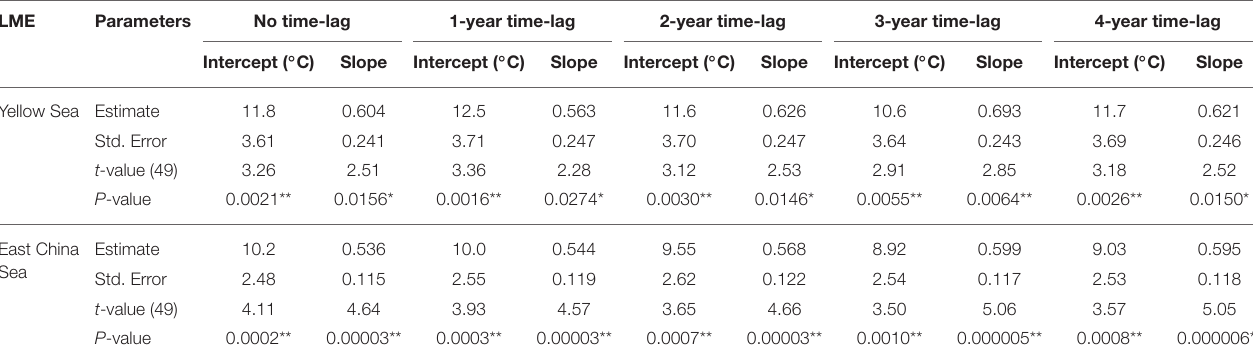
TABLE 1 | Test statistics of GLM between MTC and SST without and with time-lag (up to 4 years).